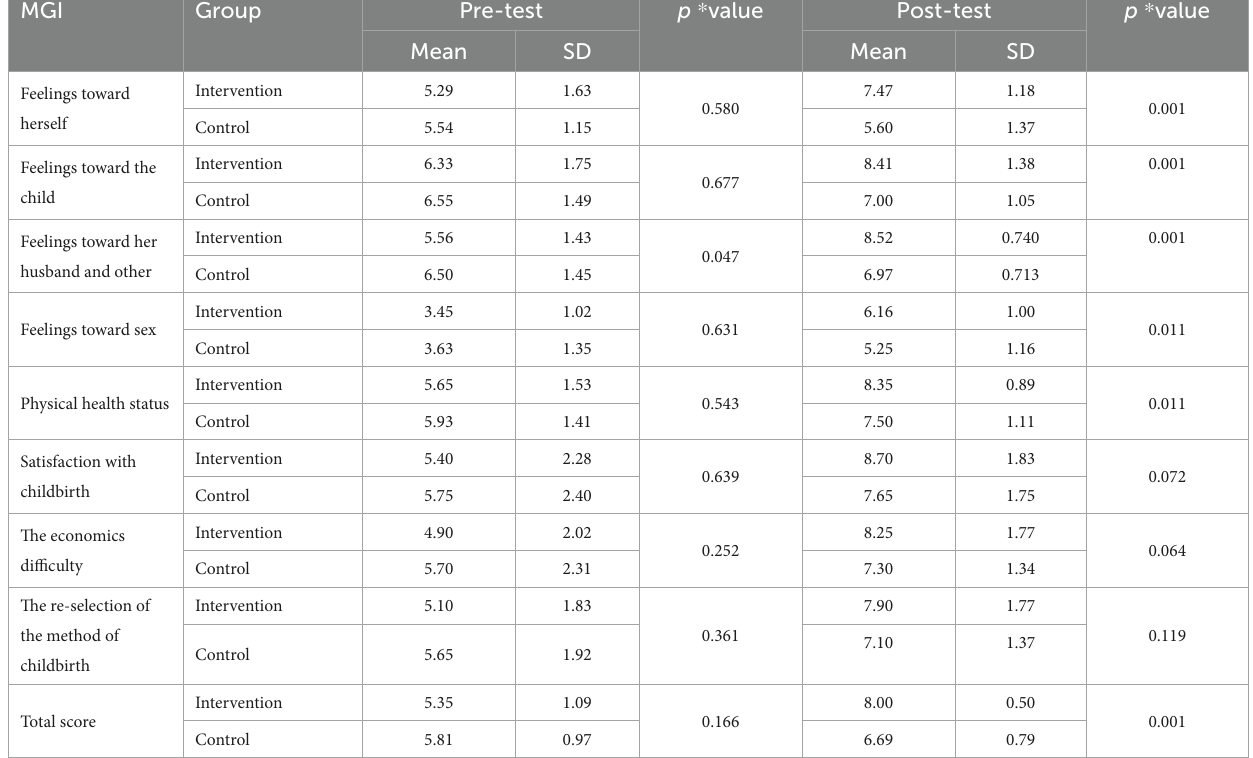
TABLE 3 The comparison of MGI scores between two groups in pre-intervention and 6 weeks after intervention.